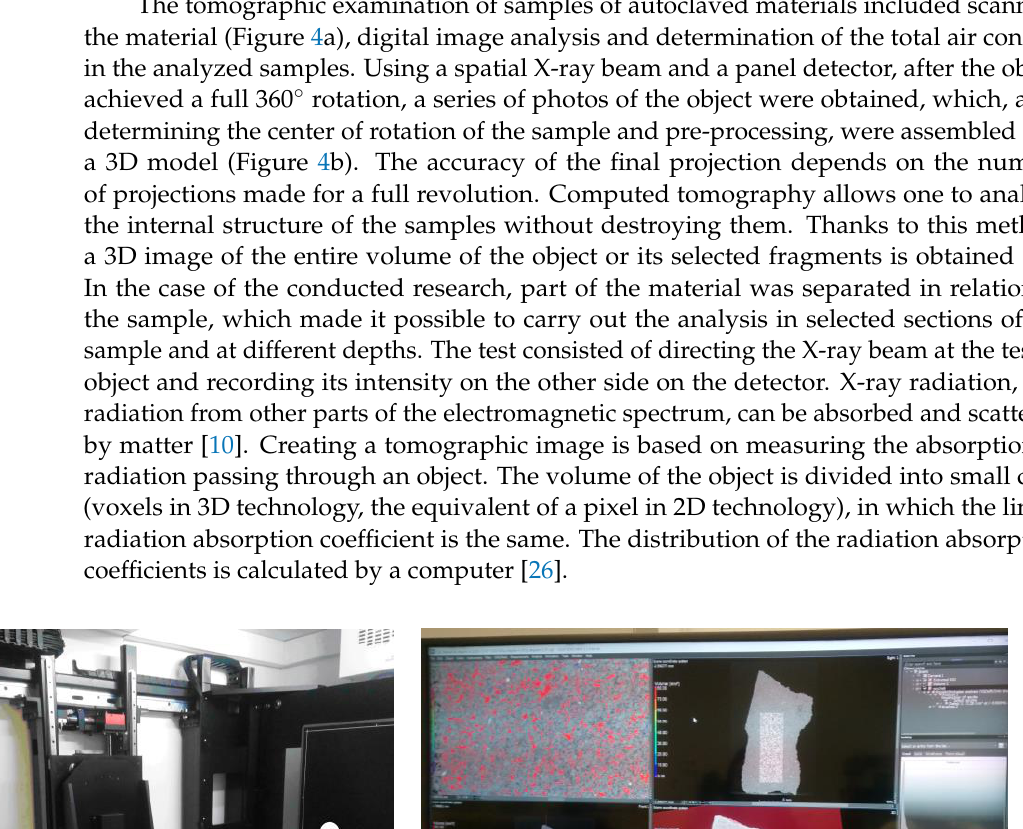
Figure 3. Basic devices used to measure the porosity of traditional silicate materials and those modified with glass sand: ( a ) Nikon XT H 225 ST computer tomograph; ( b ) QUANTACHROME ULTRAPYC 1200e mercury porosimeter.